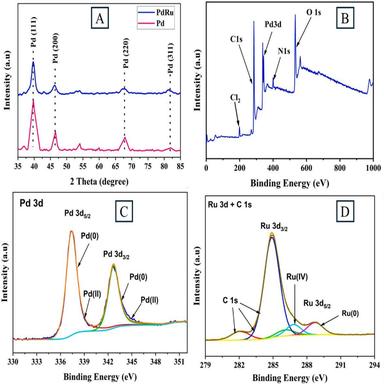
(A)The XRD pattern of Pd–Ru and Pd NcM is utilized in IMPACT designs. (B) XPS survey spectrum of PdRu (C) Pd 3d (D) C 1s + Ru 3d